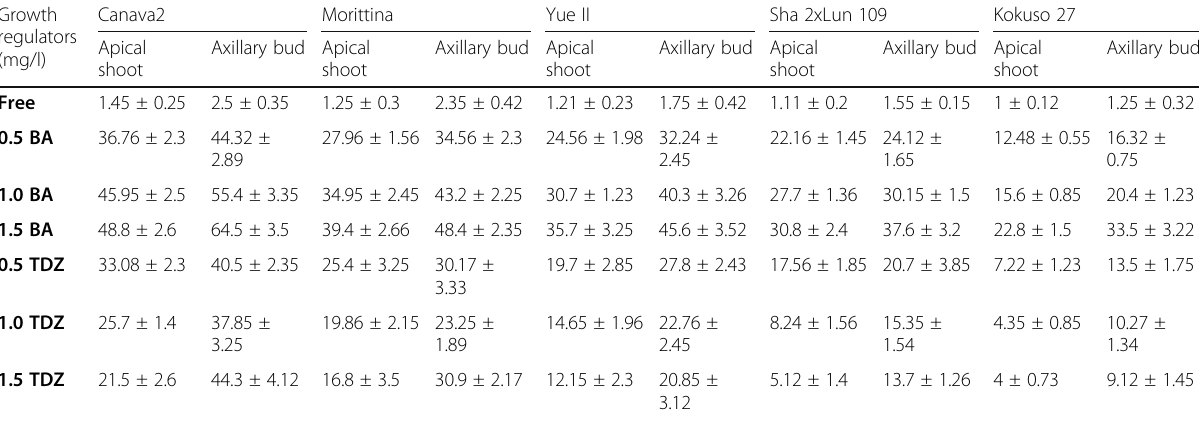
Table 1 Effect of BA or TDZ (mg/l) at different concentrations and type of explants (apical shoots or auxiliary buds) on in vitro percentage of shoots multiplication of kantava 2, morittina,yue 11, sha 2x lun 109, and kokuso 27 mulberry cultivars Growth